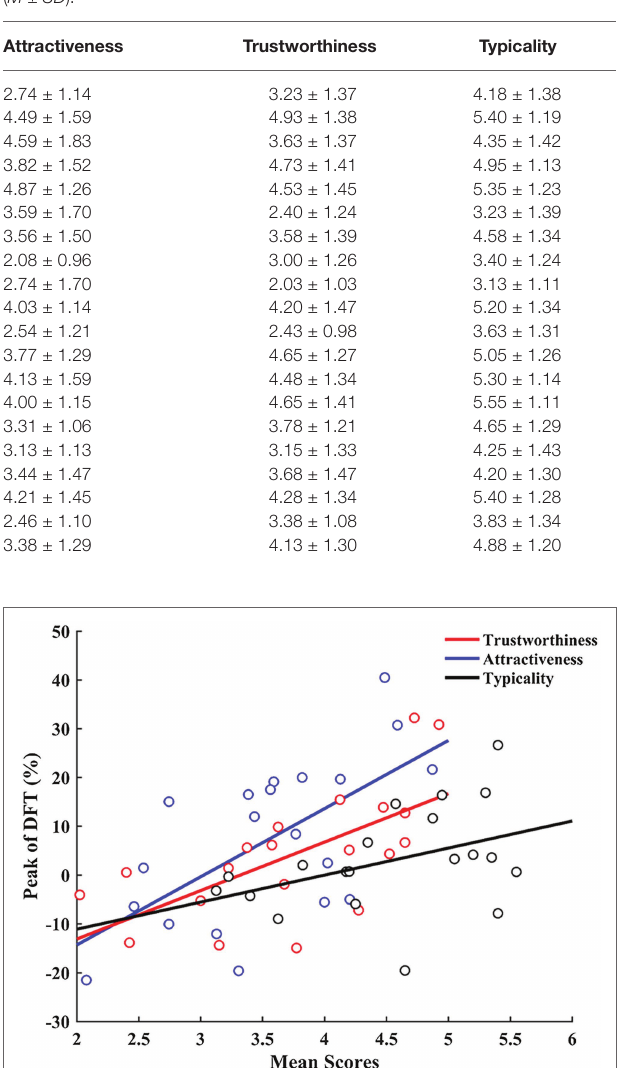
TABLE 4 | Descriptive statistics on trait judgments of each original face ( M ± SD ).